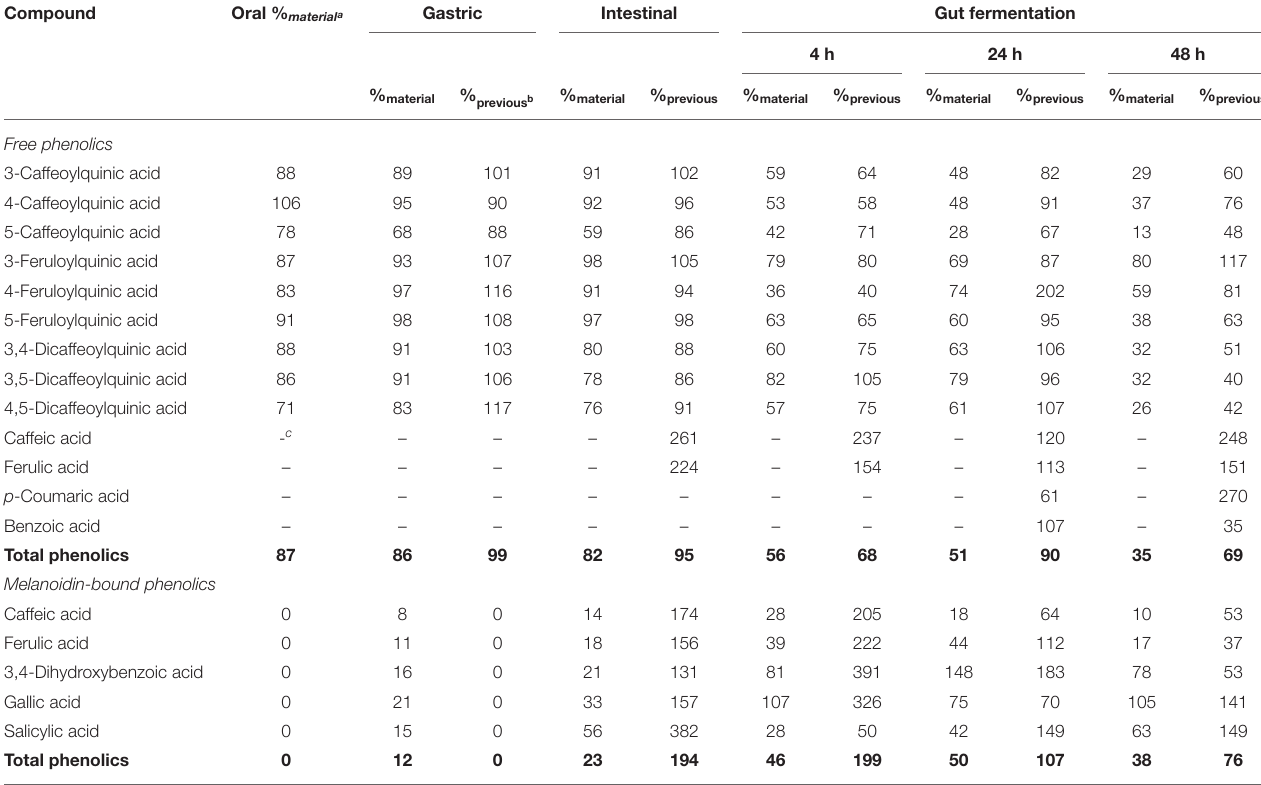
TABLE 3 | Bioaccessibility (%) of free and melanoidin-bound phenolic compounds from coffee during simulated digestion (oral, gastric, and intestinal steps) and gut fermentation.